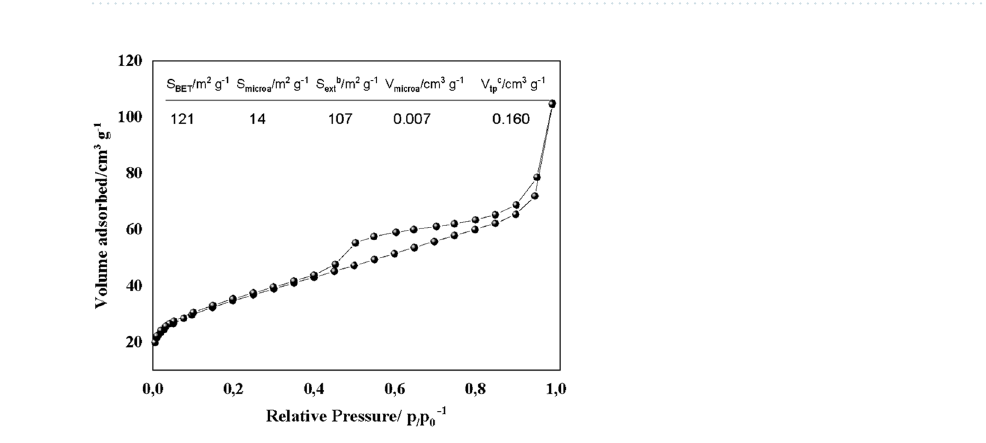
Figure 6. TEM-SAED ( a ) before, and ( b ) after immersion in SBF for 72 h. The profiles of SAED patterns ( a ) and ( b ) are shown with the indication of the reflections of HA and calcite.